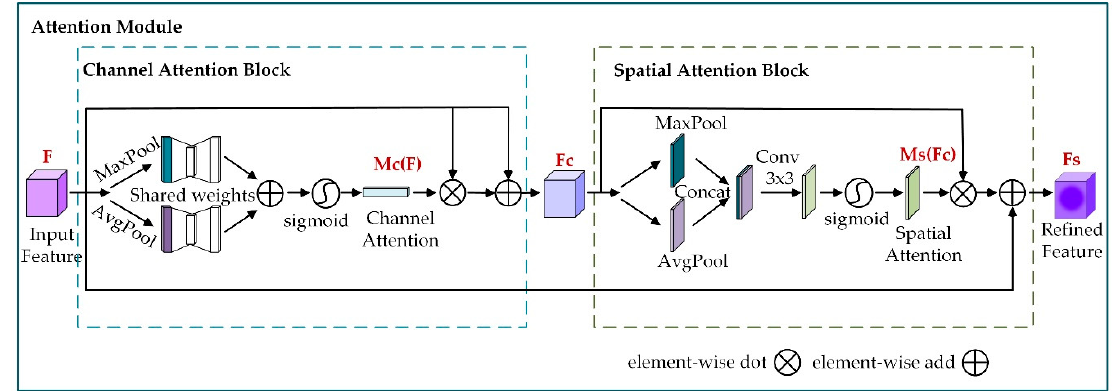
Figure 4. The whole structure of the designed attention module.